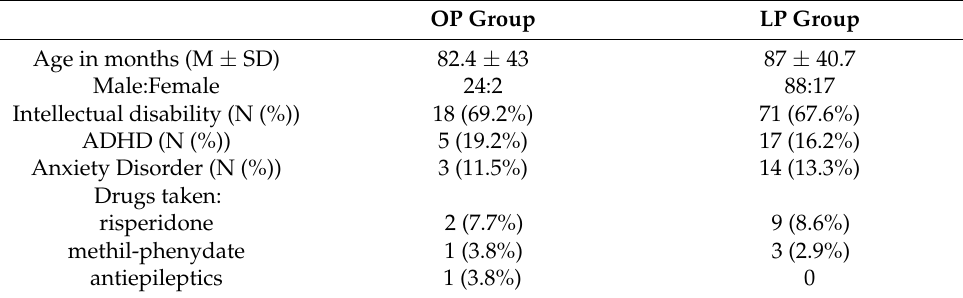
Table 1. Subjects’ characteristics at T0.